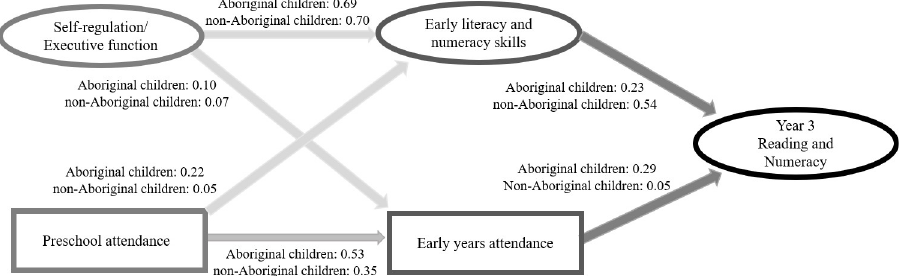
Fig 3. The mediation model with early literacy/numeracy skills and early years attendance as mediators. All path coefficients are standardised.